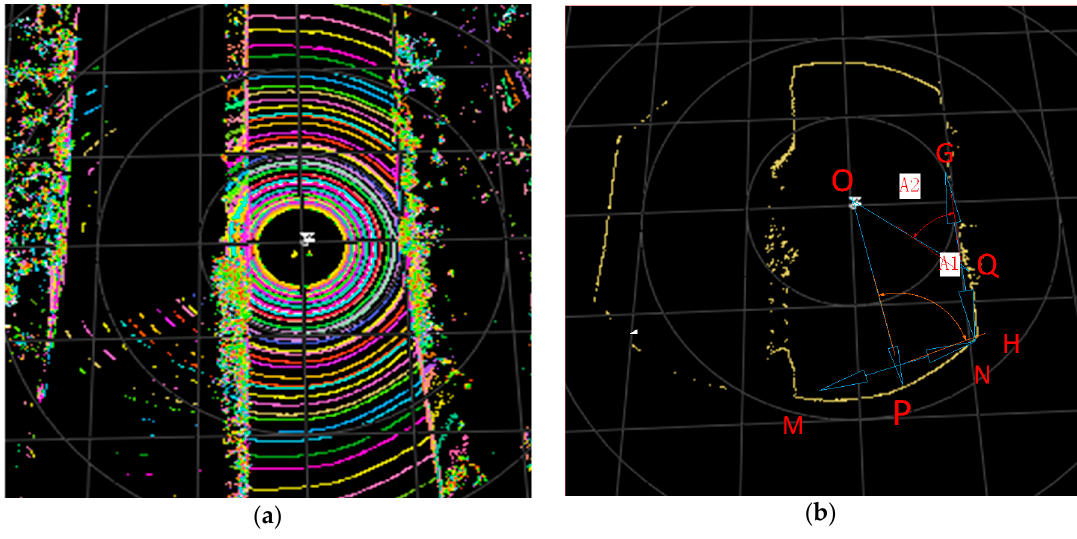
Figure 5. Schematic diagram for the construction of the tangential angle. ( a ) Map of original point cloud; ( b ) Schematic diagram.